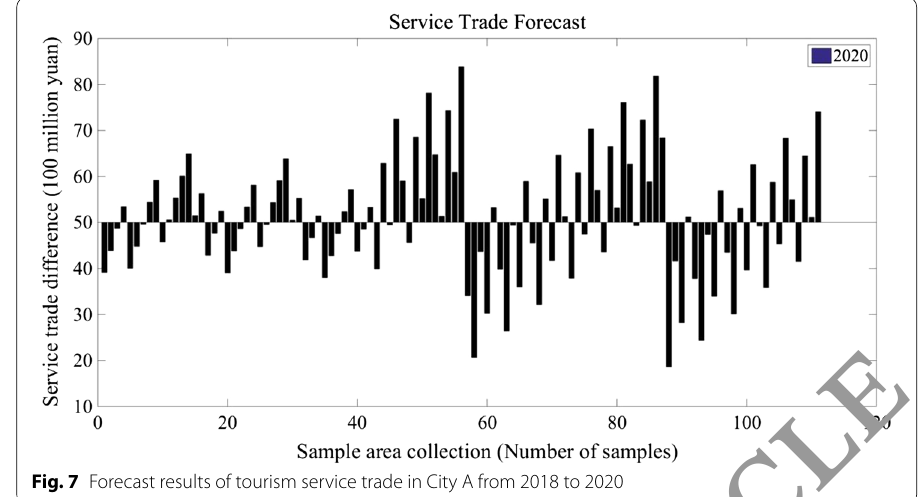
Fig. 7 Forecast results of tourism service trade in City A from 2018 to